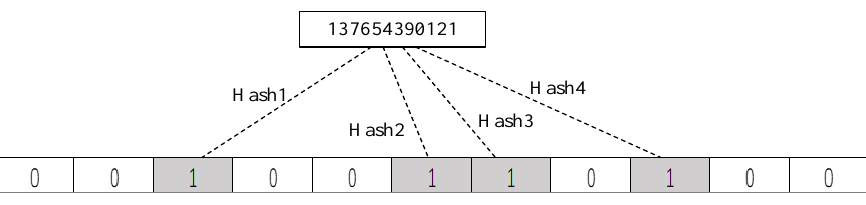
Figure 2. The diagram of Bloom Filter (BF) working principles.